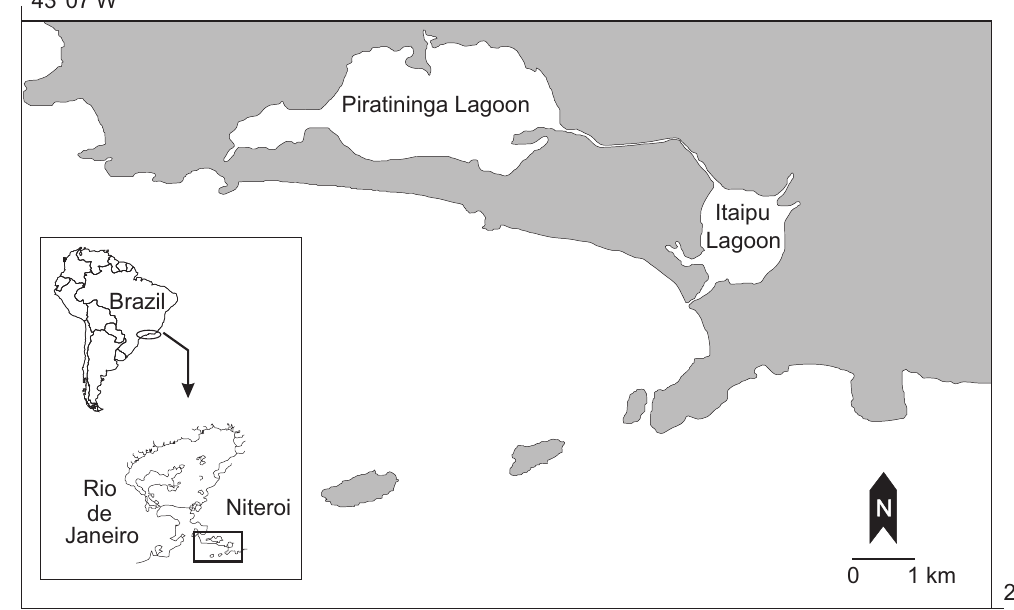
Figure 1. Location of Itaipu